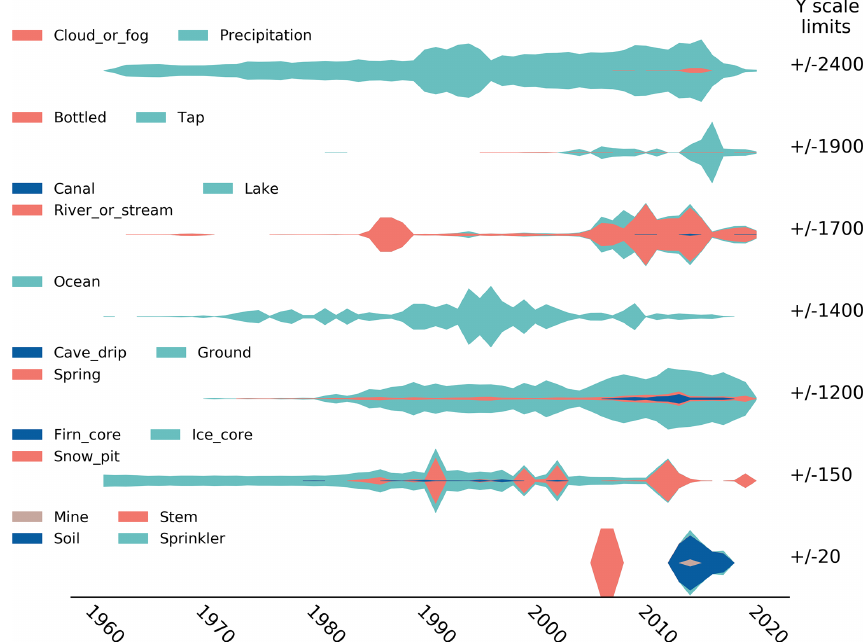
Figure 3. Temporal coverage of samples grouped by type and binned by collection year. Plots are ordered by most numerous sample types to most “niche” sample types, and the y scale varies by plot. The sample is attributed to the latest year within the collection period, even if it may represent integrated sampling across multiple years (e.g., Precipitation). We do not show the entire temporal range of Ice_core